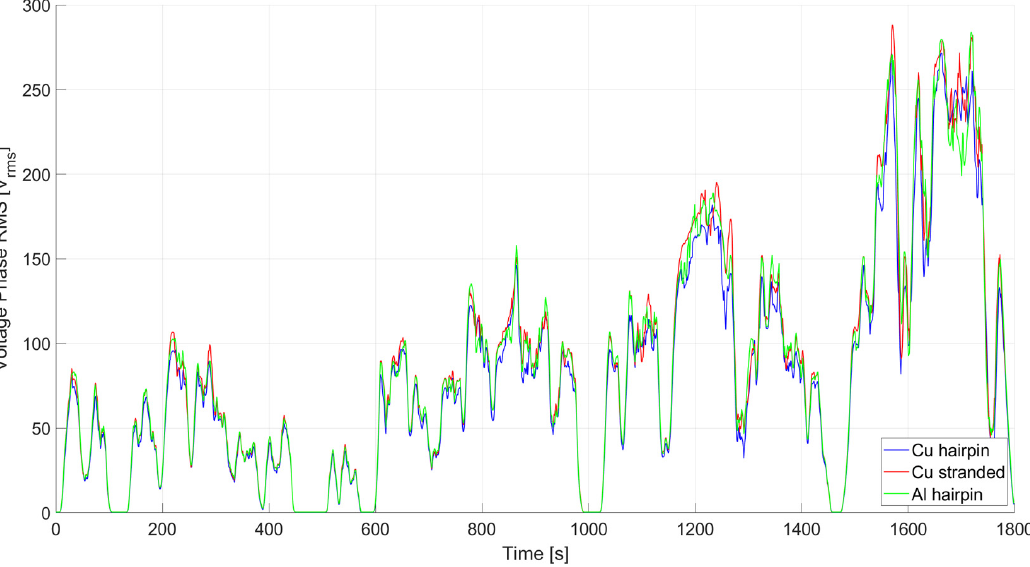
Figure 11. Efficiency, stator phase current ( top ), and voltage ( bottom ) values for WLTP class 3 drive cycle.